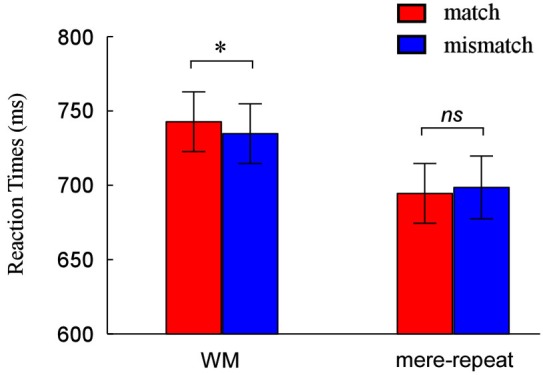
Reaction times (RTs) and error rates as a function of match and mismatch condition when the cue was held in WM and when it was merely identified. * p < 0.05, ** p < 0.01, *** p < 0.001.